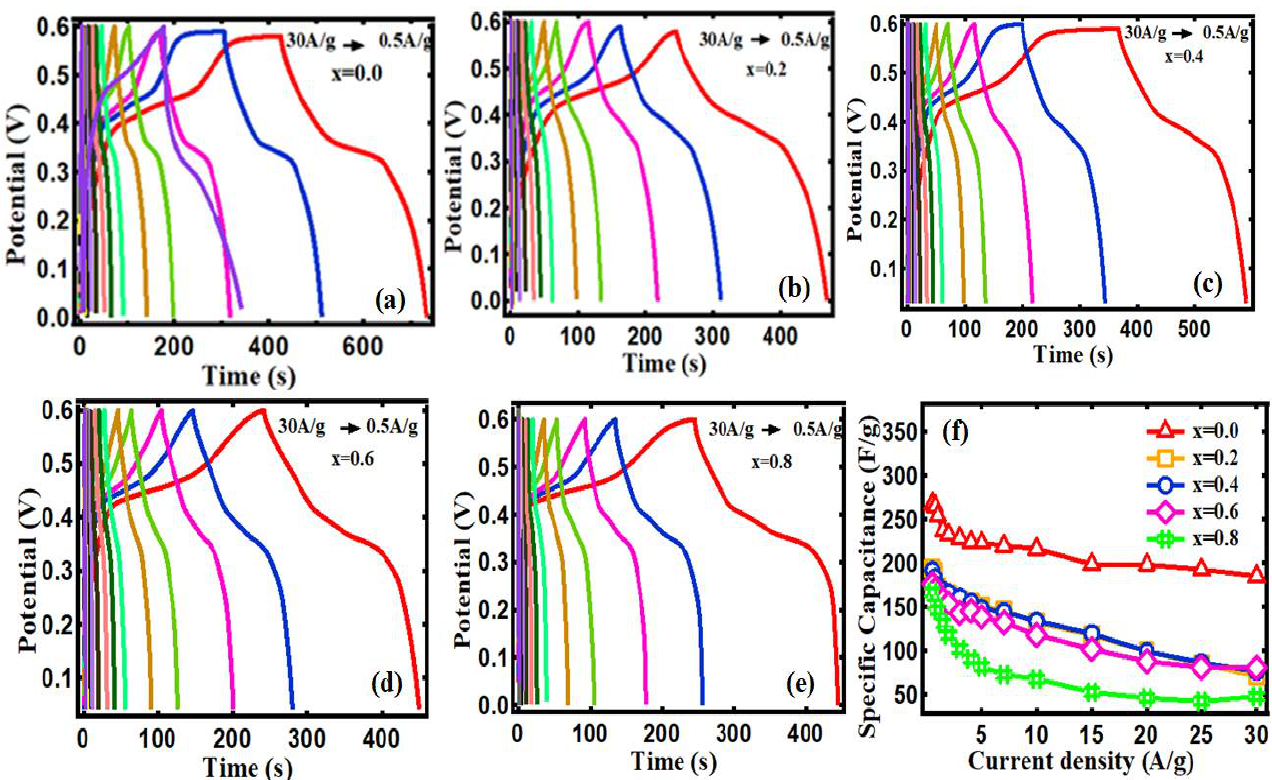
Figure 6. ( a – e ) Charge-discharge curves of Ni 1-x Al x Co 2 O 4 , electrode measured in the current density window of 0.75 to 30 A/g under 3 M KOH electrolytes. Figure ( f ) Comparison of specific capacitance as a function of current density.